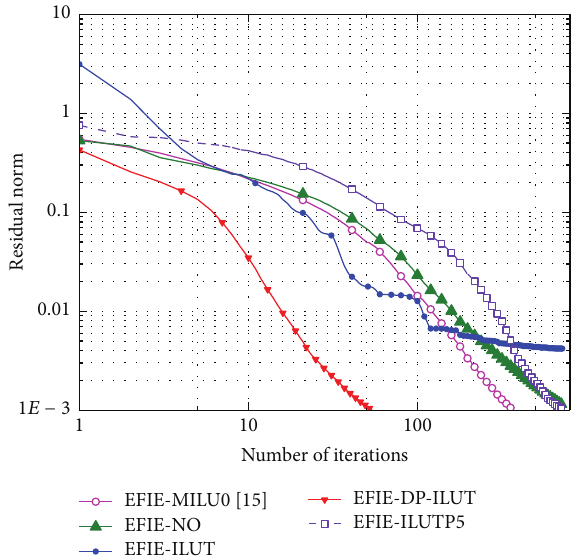
Figure 4: The convergence history of GMRES algorithms with different integral operators and preconditioners in the almond example.